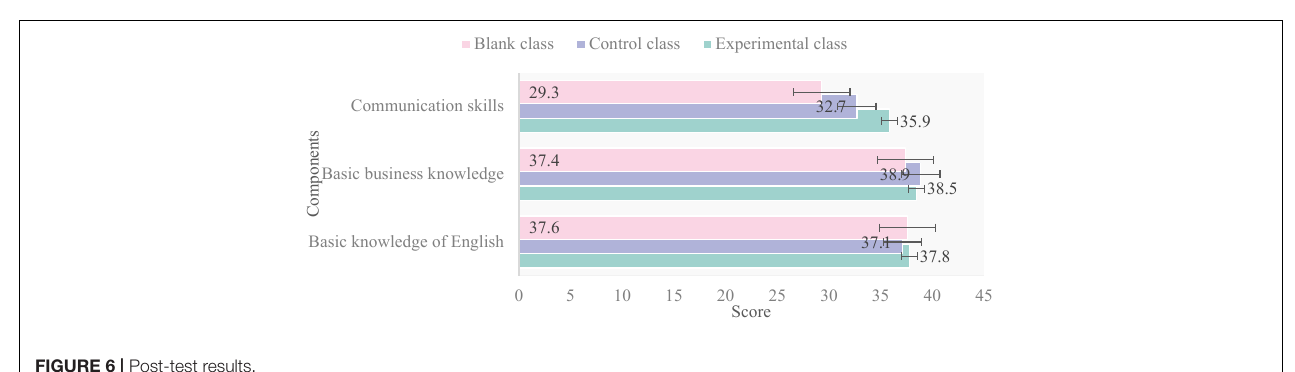
FIGURE 6 | Post-test